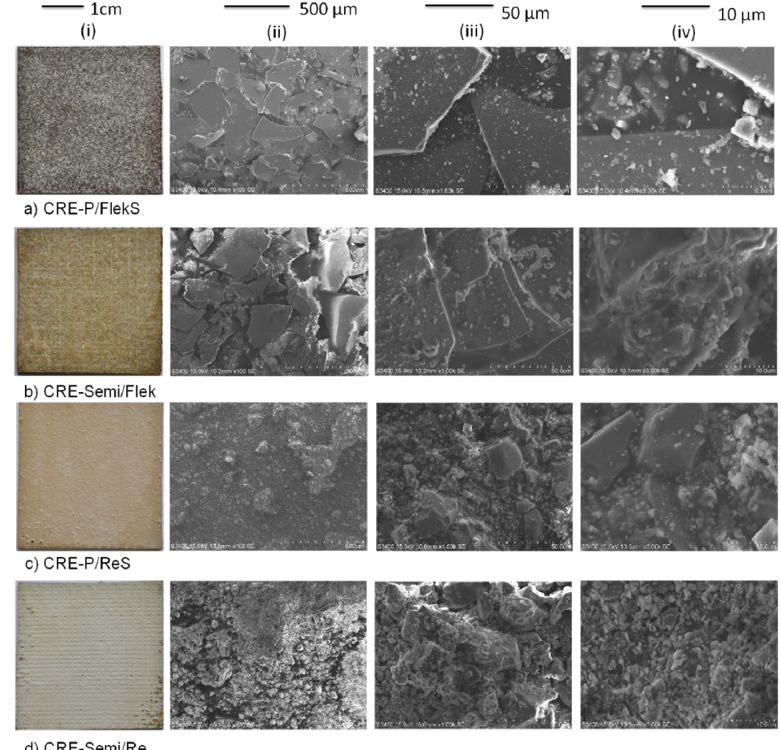
Figure 2. Digital photographs ( i ) and scanning electron microscopy (SEM) ( ii – iv ) images of ( a ) CRE ‐ P/FlekS, ( b ) CRE ‐ Semi/Flek, ( c ) CRE ‐ P/ReS and ( d ) CRE ‐ Semi/Re sample surfaces at various magnifications.